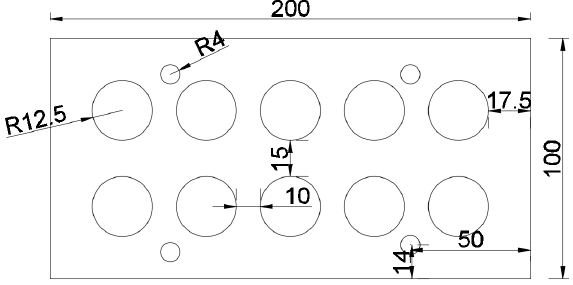
Figure 4. The dimension, puncture distribution and anchor holes of the perforated steel plate (all dimensions are in mm).